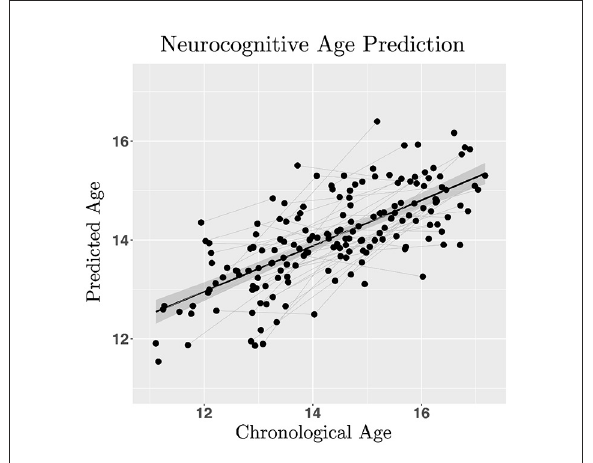
FIGURE3 Regularized regression was used to estimate neurocognitive age in a training sample with leave-one-out cross validation to estimate linear model hyper- parameters (lambda = 0.083; L2-norm ridge regression with alpha = 0) minimizing mean squared error for predicting age with inhibitory control, risk/reward processing and emotional processing latent factors in a test sample (50% participants split into train/test datasets). Model performance was assessed by computing the ratio between the mean cross-validated error and variance of observed age in the validation dataset (R 2 = 0.51). The neurocognitive maturity index is computed by subtracting the predicted neurocognitive age from the chronological